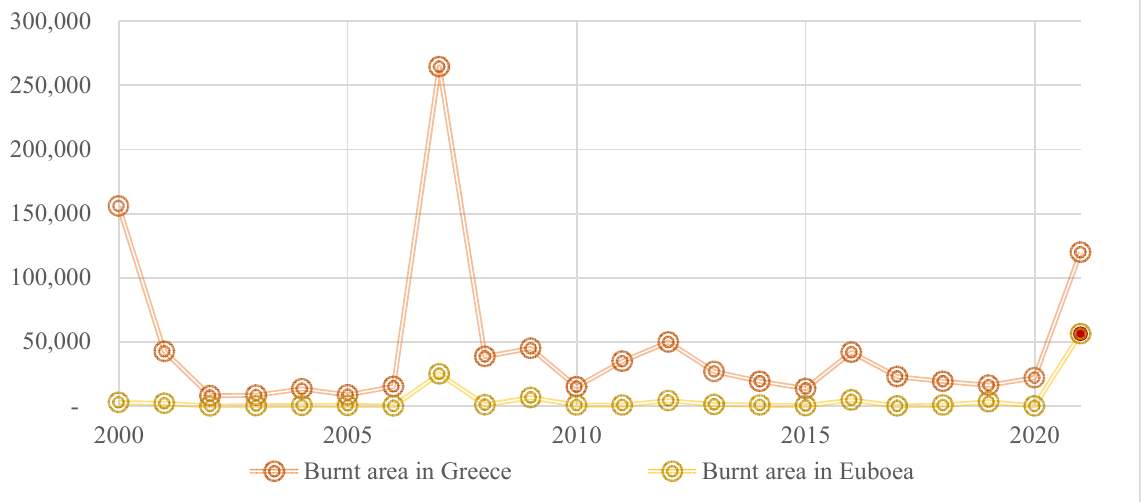
Figure 9. The total area of the fire was adapted by [76,77]. The evolution of the fire, adapted graphically in Google Earth [73] by satellite imagery [78,79], calibrated by the reports of 112 Emer ‐ gency Communications Service [80].